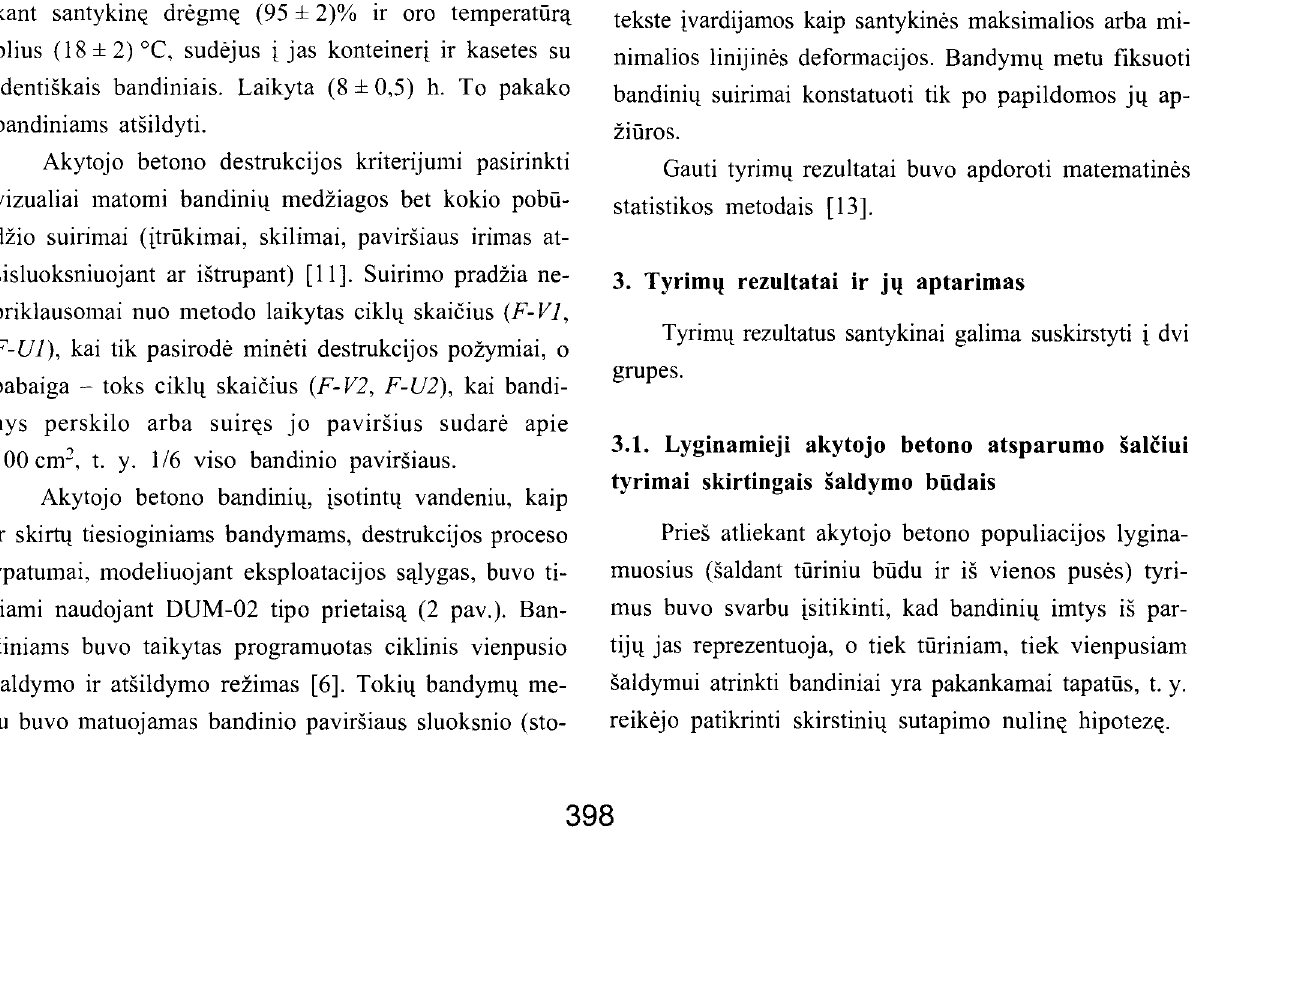
Fig 2. General view of the apparatus DUM-02 specimen